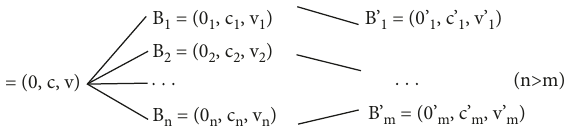
Figure 2: Diamond thinking